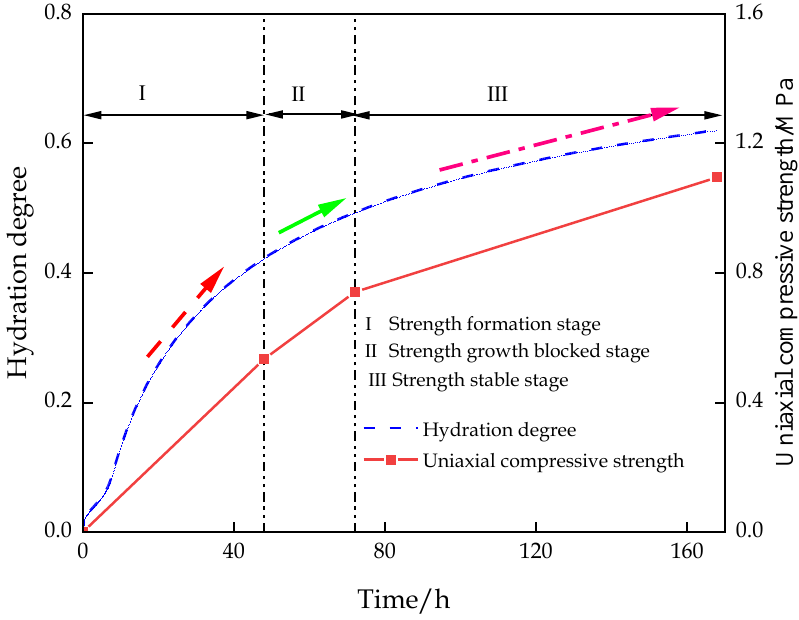
Figure 15. Variation curves of porosity and UCS over time.